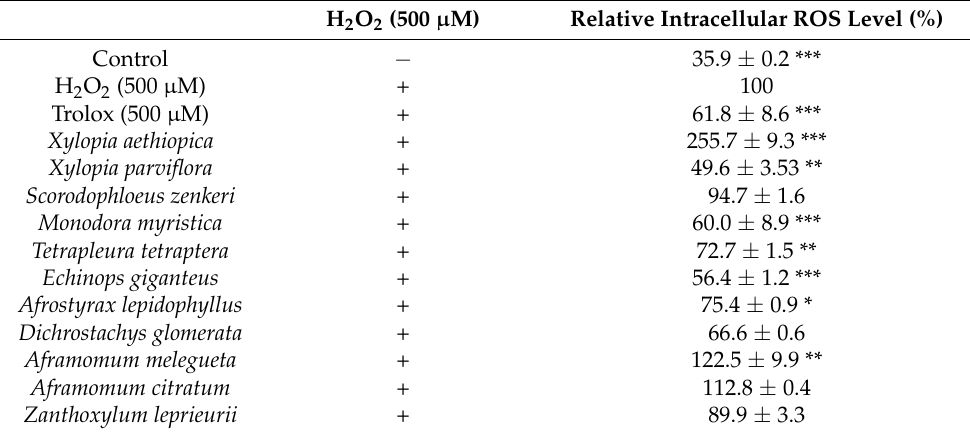
Table 2. Intracellular ROS production in differentiated SW 872 adipocytes: effect of spice extracts.